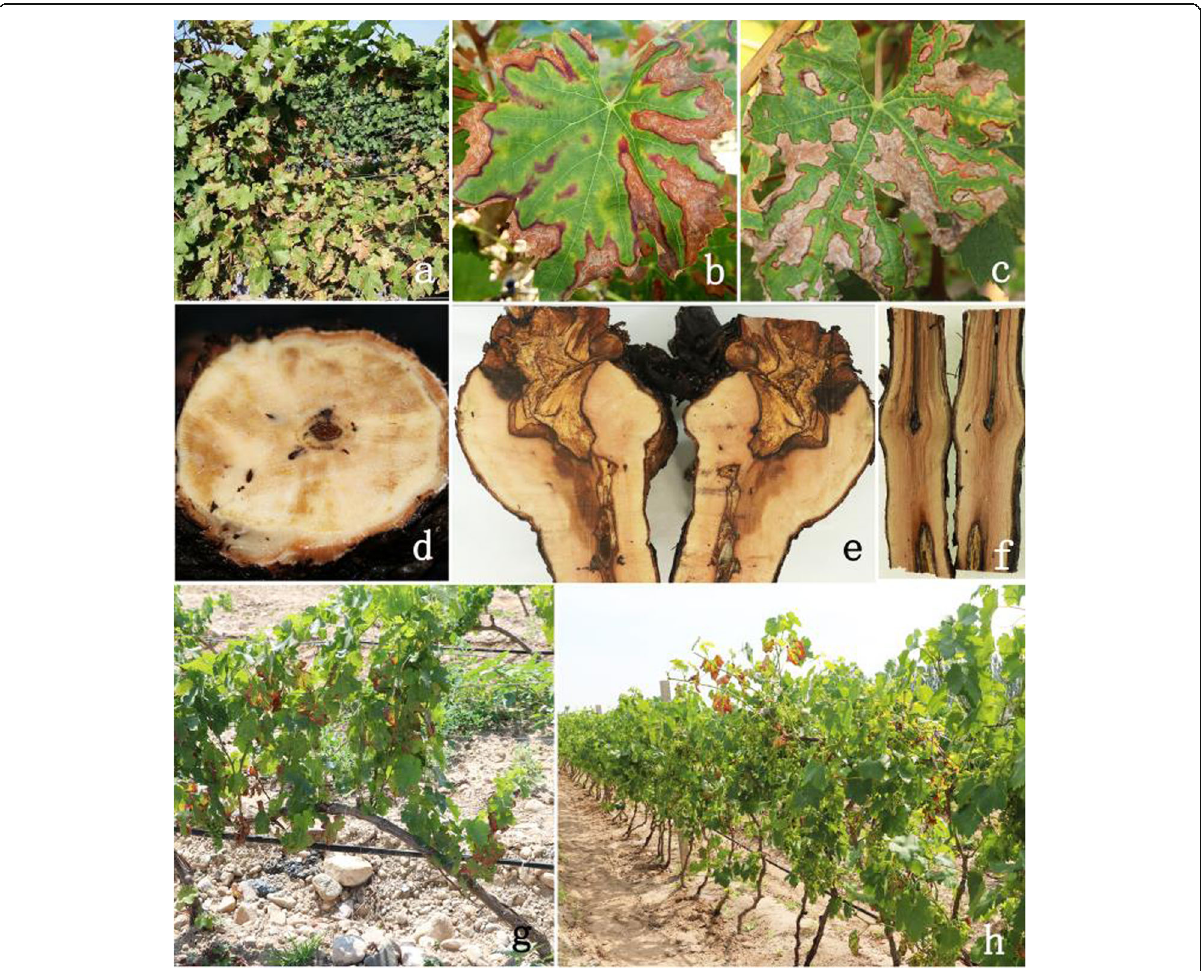
Fig. 1 The training systems in the surveyed vineyards and symptoms on 19-year-old ‘ Cabernet ’ grapevines. a – c Foliar symptoms of GLSD-like (Esca complex) disease, initially appeared as chlorotic spots and subsequently coalesced, turned dark red, and finally became necrotic. d – f Internal symptoms of the same vine with foliar symptoms: discolored wood showing white rot and brown necrosis. g , h The mini “ J ” and vertical training systems in the surveyed vineyards in Hebei and Ningxia provinces,